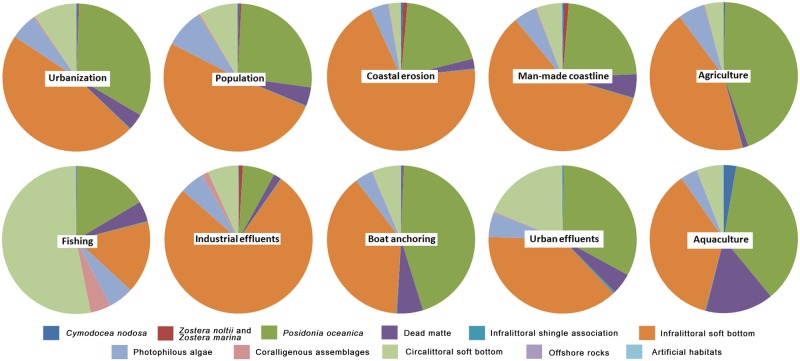
Repartition of the total cumulated value of each pressure in function of the habitats.Each pie chart indicates the repartition (in percent) of the total cumulated value (sum of all 20 x 20 m cell values concerning a pressure) of each individual pressure (name indicated in the white rectangles) in function of the habitats.